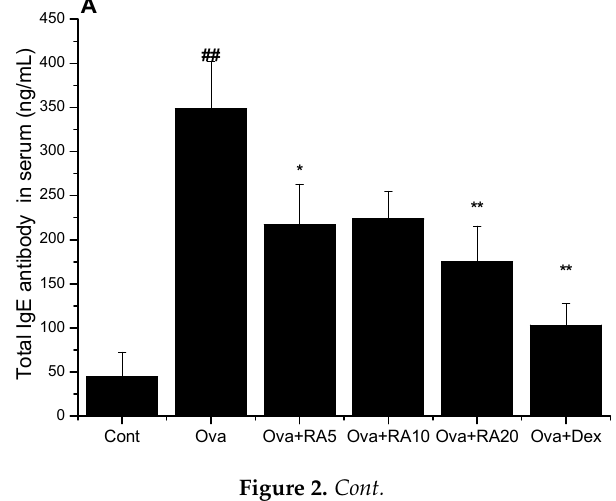
Figure 2. Cont. Figure 2.